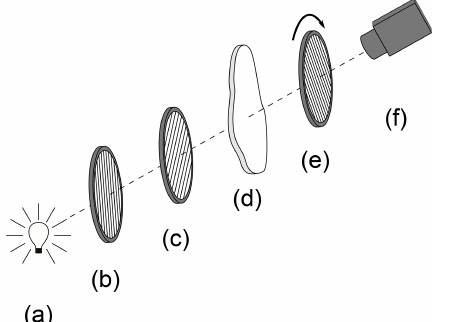
Figure 6. Grey field polariscope (Horn et al., 2005) consisting of (a) a light source, (b) a linear polarizer, (c) a quarter wave plate, (d) a probe, (e) a rotating linear polarizer and (f) a